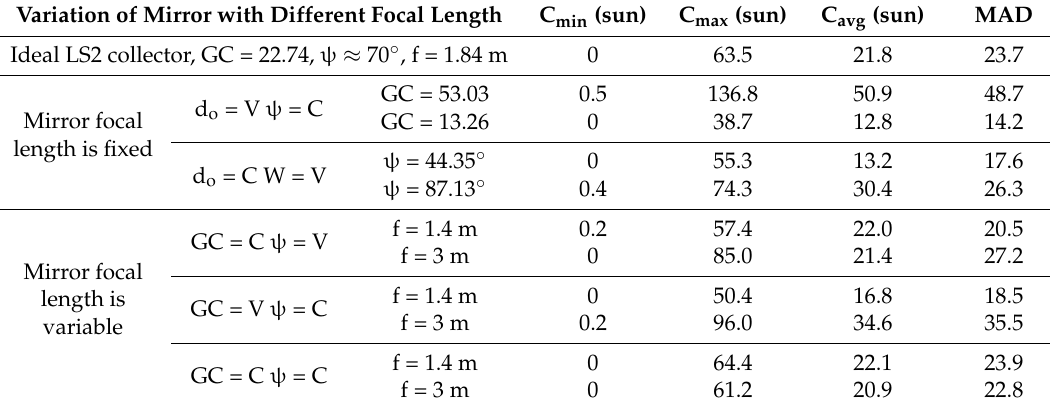
In the table: LS2 = Luz Solar 2 collector, sun = unit of light concentration = 1 kW/m 2 ; C min , C max and C avg , and MAD stand for minimum, maximum and average light concentration, and Mean Absolute Deviation; GC =